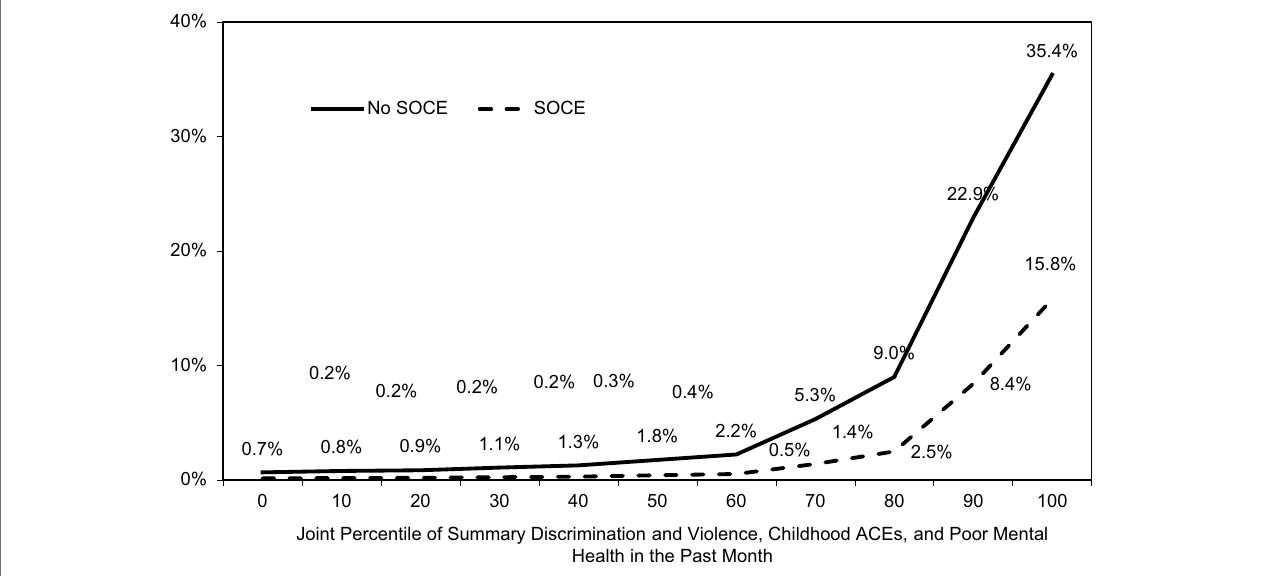
FIGURE 1 | Predicted probability of current suicide attempt with increasing minority stress, adverse childhood experiences (ACEs) and poor mental health, by experience of sexual orientation change efforts (SOCE): probability sample of United States sexual minorities 2016–2018 ( n = 1,518). Source : Generations Data, Wave 1, Williams Institute 2016 ( n = 1,518). Shown are predicted outcomes from Table 3 suicide attempts